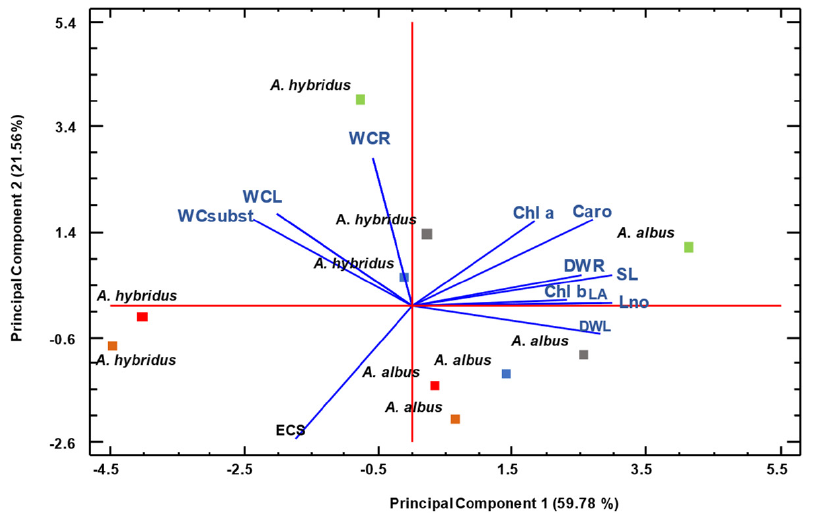
Figure 9. Principal Component Analysis (PCA) performed with mean values of substrate parameters (EC and water content) and parameters measured in plants: number of leaves (Lno), stem length (SL), leaf area (LA), dry weight of roots (DWR) and leaves (DWL), water content of roots (WCR) and leaves (WCL), chlorophyll a (Chl a), chlorophyll b (Chl b) and carotenoids (Caro). Colours used for the treatments: control in green, 150 mM NaCl in grey, 300 mM NaCl in blue, 450 mM NaCl in red and 600 mM NaCl in brown.